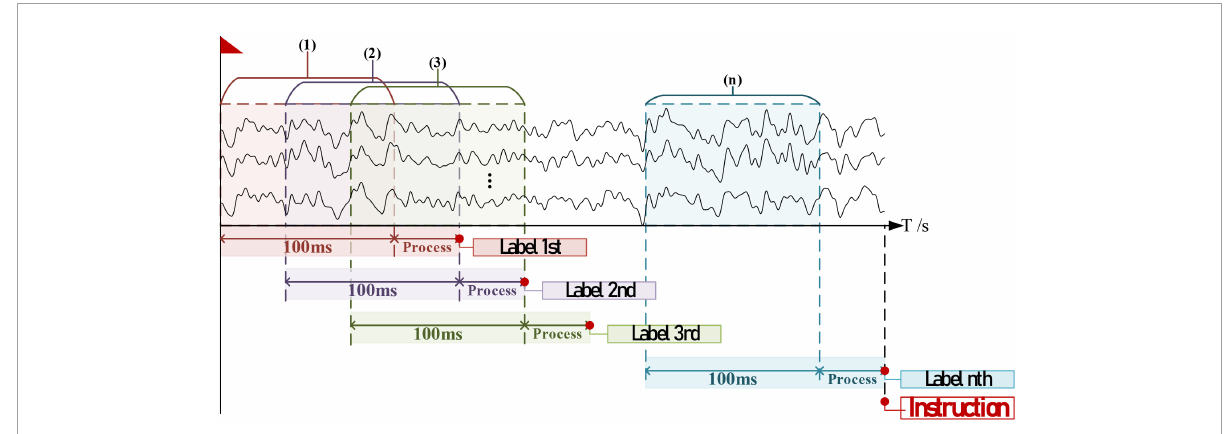
FIGURE7 The timing diagram for one valid instruction generation, supposed that all collected data were slight-facial expression (sFE)- electroencephalograms (EEGs) intending for the same